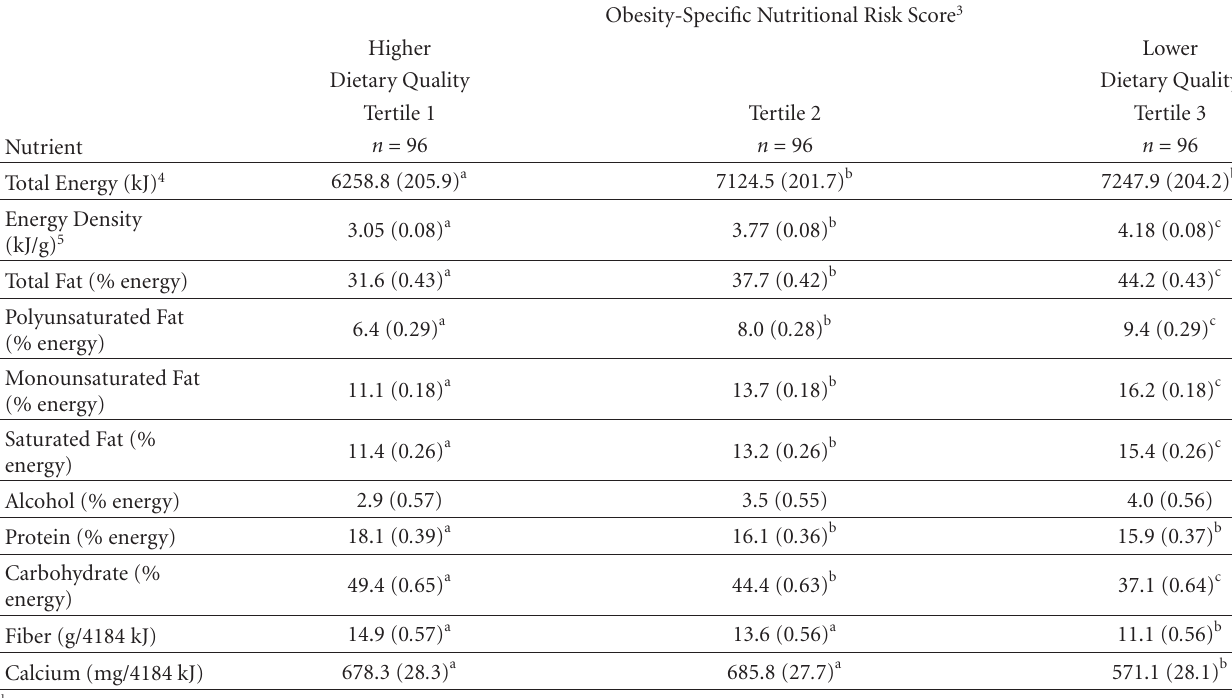
Table 2: Baseline daily nutrient intake profiles of 288 healthy women without abdominal obesity (waist circumference ≤ 88 cm) in the Framingham O ff spring-Spouse Study according to dietary quality 1,2 .